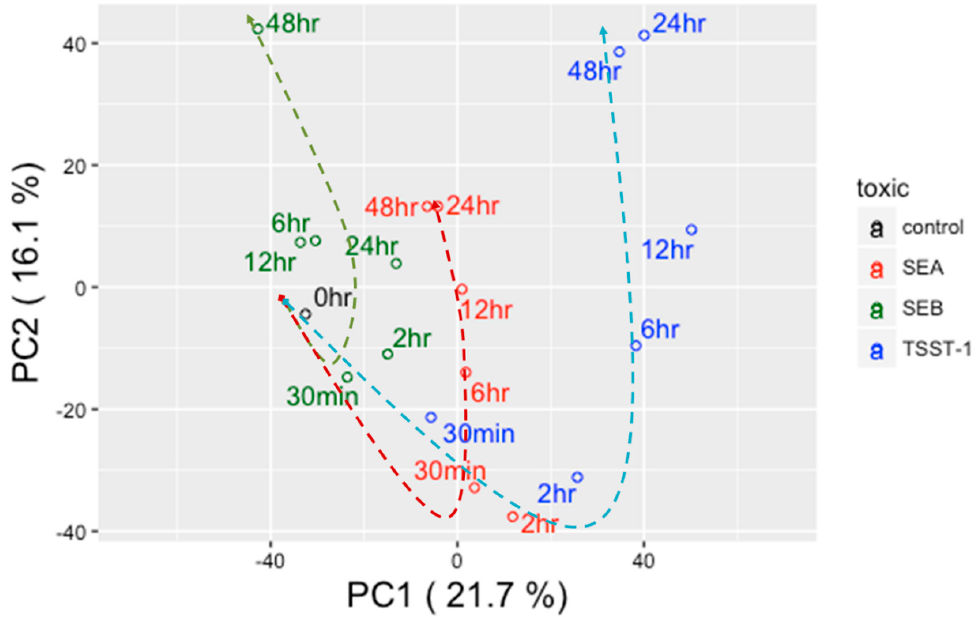
Figure 1. Principal components analysis (PCA) of time-resolved gene expression values. Black-, red-, green-, and blue-colored open circles represent control, SEA, SEB, and TSST-1, respectively. Dotted lines trace the temporal shifts caused by different toxins; here red, green, and blue dotted lines represent control, SEA, SEB, and TSST-1, respectively.